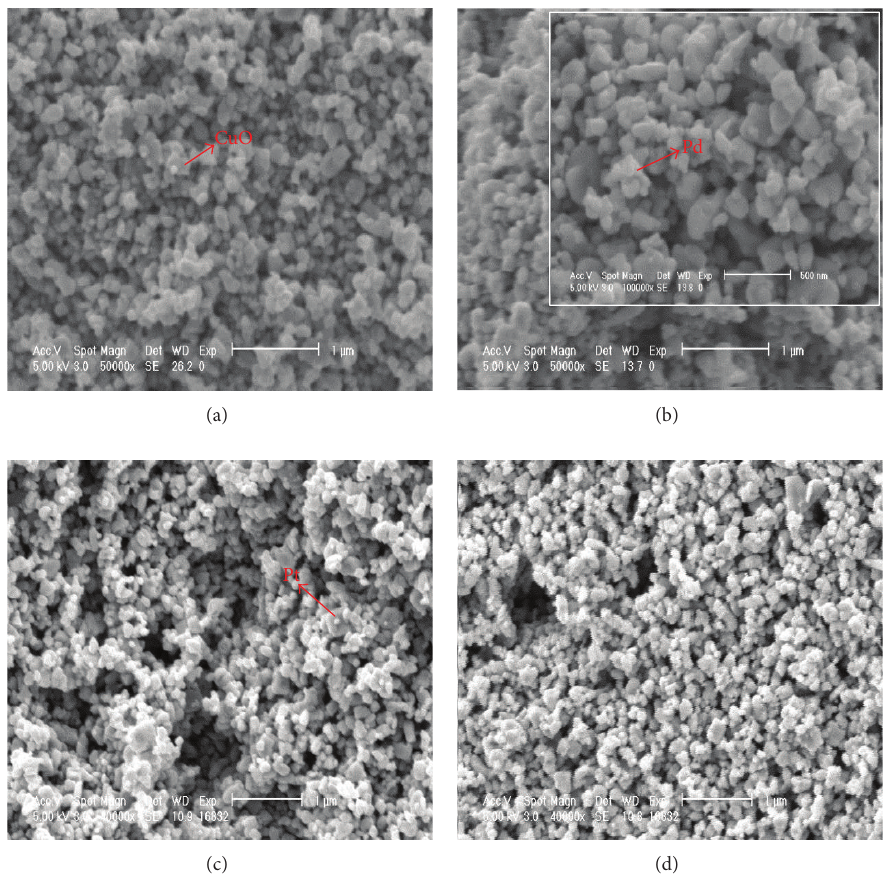
Figure 2: SEM images of WO 3 and modified WO 3 samples: (a) CuO/WO 3 , (b) Pd/WO 3 , (c) Pt/WO 3 , and (d) pure WO 3 .